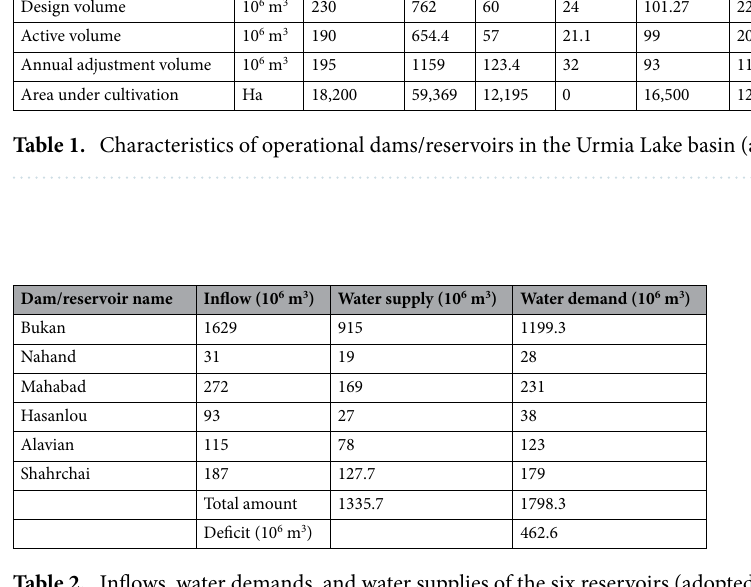
Table 2. Inflows, water demands, and water supplies of the six reservoirs (adopted from 23 ).